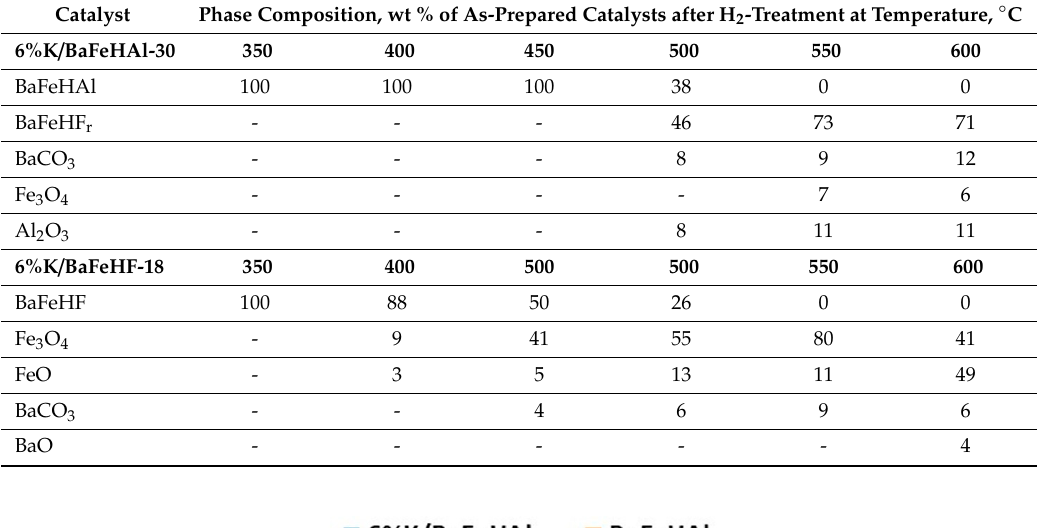
Table 2. Phase composition of 6%K / BaFeHAl-30 and 6%K / BaFeHF-18 after H 2 -reduction.